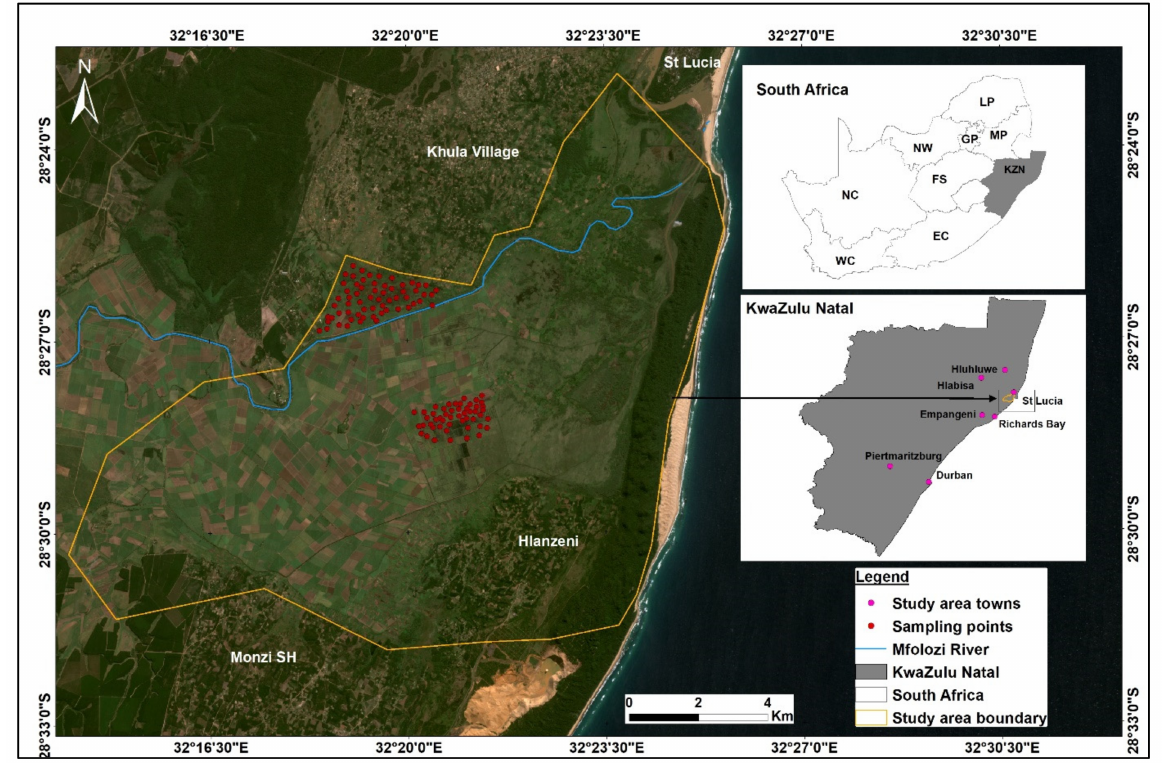
Figure 1. Geographic location of the study area in KwaZulu Natal province, South